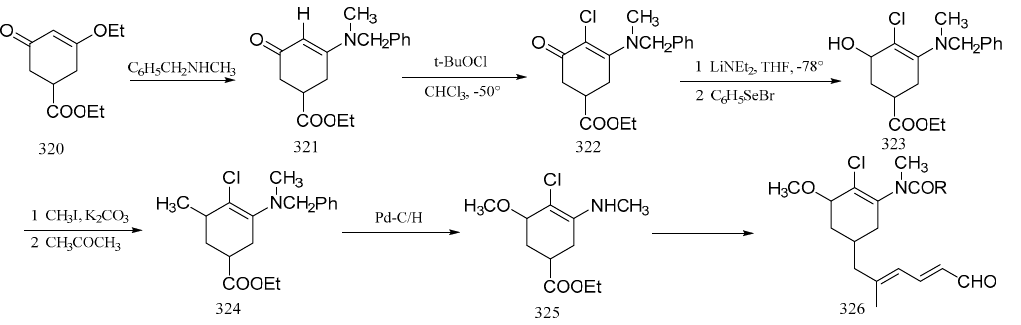
Figure 14. Synthesis of the benzenoid-associated intermediates of maytansine. Corey et al. [98] used a high degree of stereo-selectivity in order to synthesize a strategic intermediate corresponding to C10-N fragment of maytansine. Starting from the raw materials, either ( 327 ) or ( 328 ), the iodide ( 329 ) was prepared through three steps. The iodide ( 329 ) was transformed efficiently and selectively into the E-tri-substituted olefinic derivative ( 330 ), through a cross coupling reaction with a specially designed mixed Gilman reagent ( 331 ) (which involved the use of a cuprate). The mixed Gilman reagent ( 331 ) was highly soluble, which allowed the whole process to be conducted under homogeneous conditions in a tetrahydrofuran solution. This led to a higher yield of coupling product. Oxidation of compound 330 produced the aldehyde ( 332 ). The α -trimethylsilyl derivative of acetaldehyde N - t -butylimine was converted to the α -lithio derivative, by reaction with sec-butyllithium in dry ether under argon. This allowed the aldehyde ( 332 ) to react